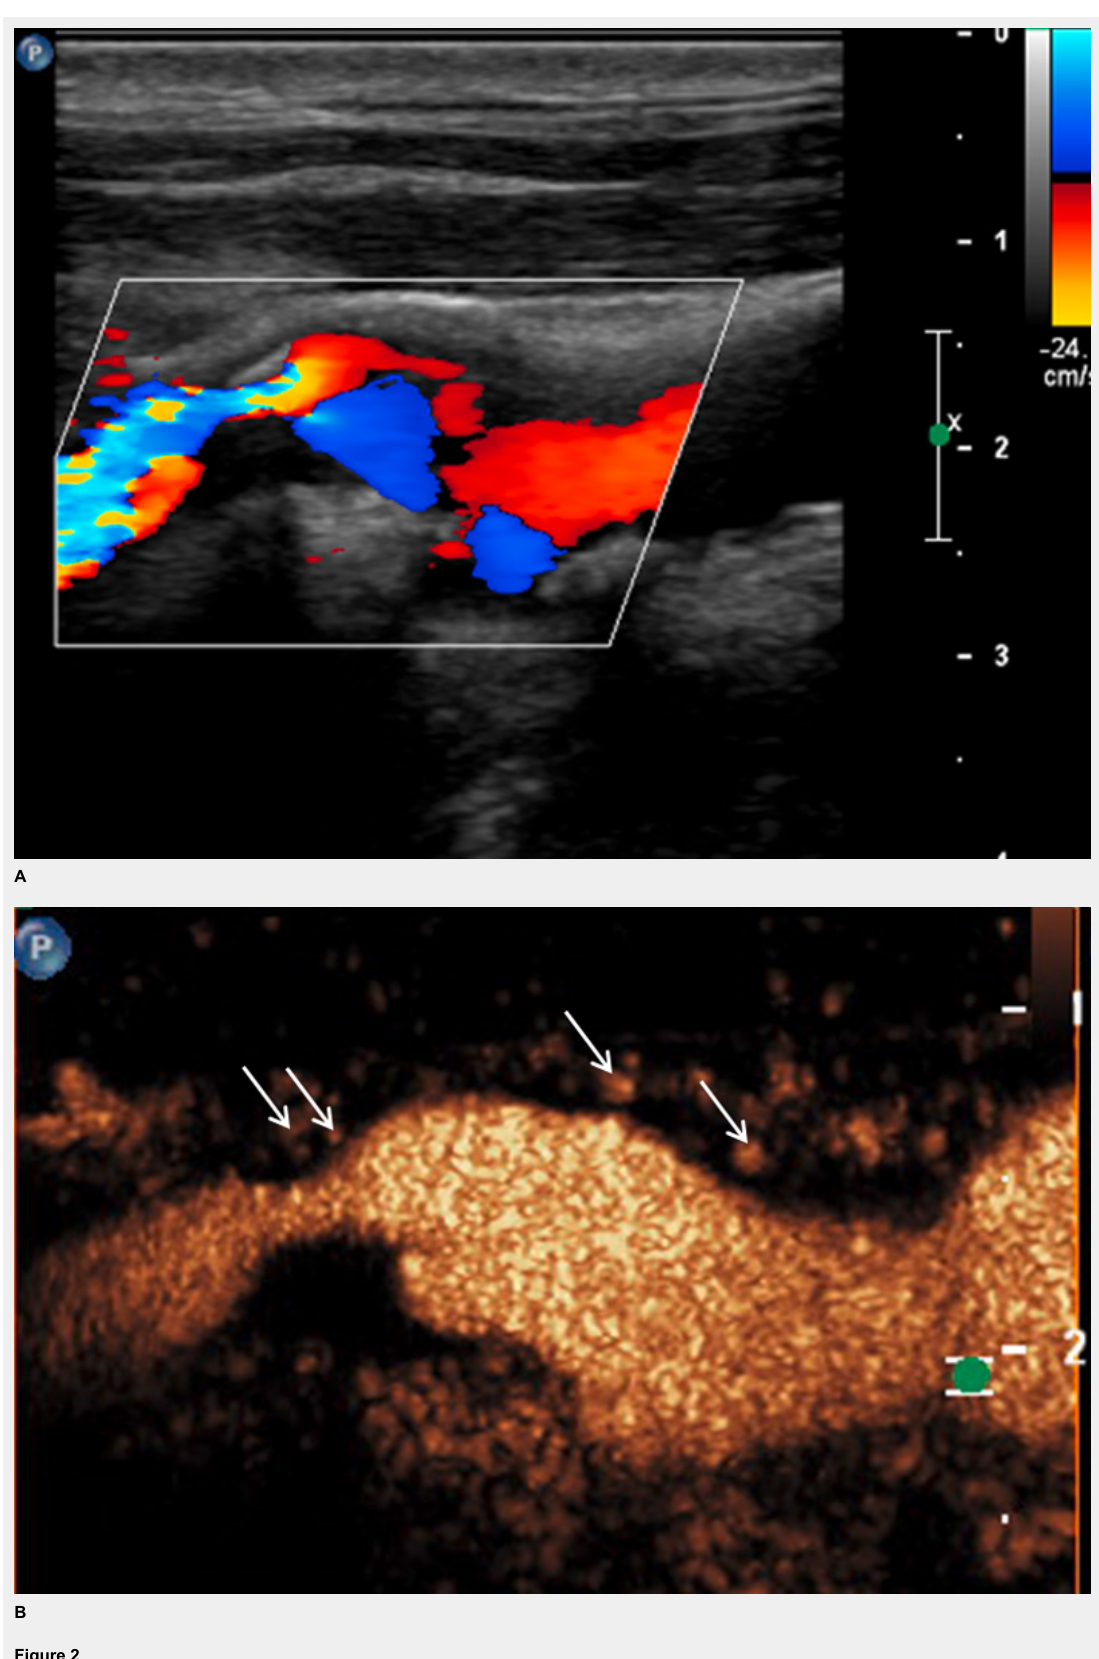
Figure 2 A 61-year-old patient with asymptomatic high-grade stenosis at the origin of the left internal carotid artery on colour Doppler ultrasound (A). Moderate intraplaque neovascularisation within the carotid stenosis at the near wall on CEUS imaging (arrows) and no neovascularisation at the far wall